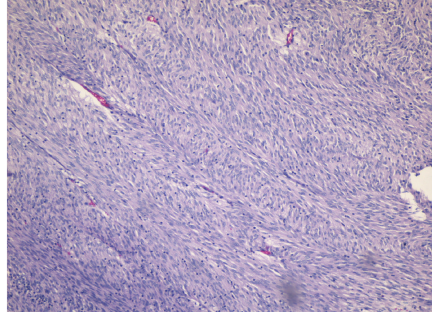
Figure 3: Microscopic finding: histological examination showing bundles of spindle cells with elongated nuclei and significant mitotic figures (H and E stain;